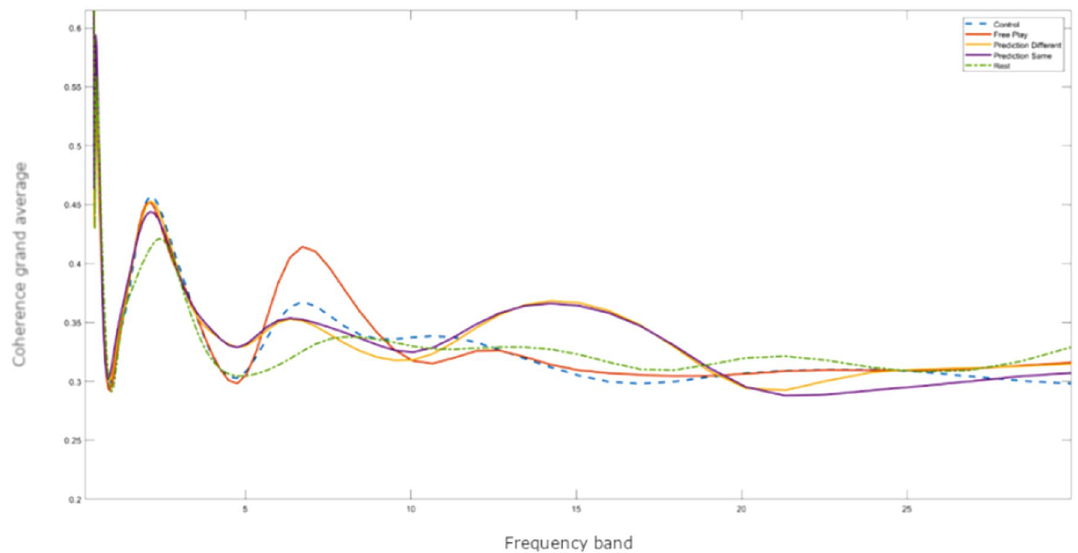
Figure 7. A plot displaying the grand average of coherence over power in all of the experimental conditions and the resting state. The coherence grand average (y axis) over the whole length of the condition frequency band (x axis) in the different conditions: Control (blue), Free Play (red), Prediction-Different Action (yellow), Prediction- Same Action (magenta), Rest